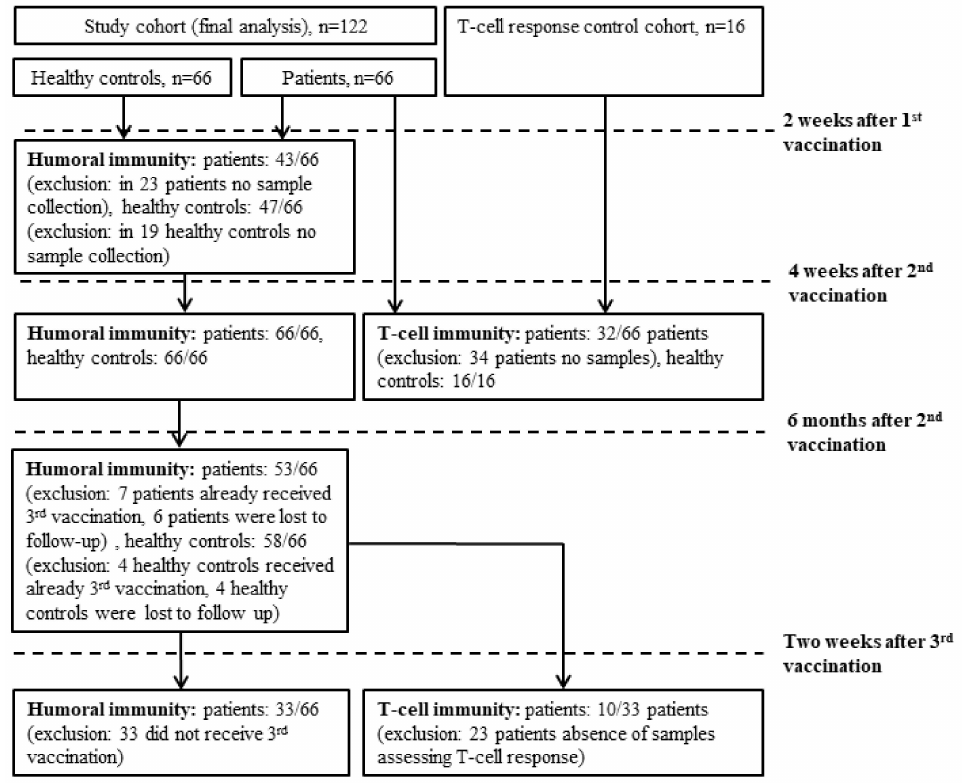
Figure 1. Flow chart demonstrating the cohorts included into the different